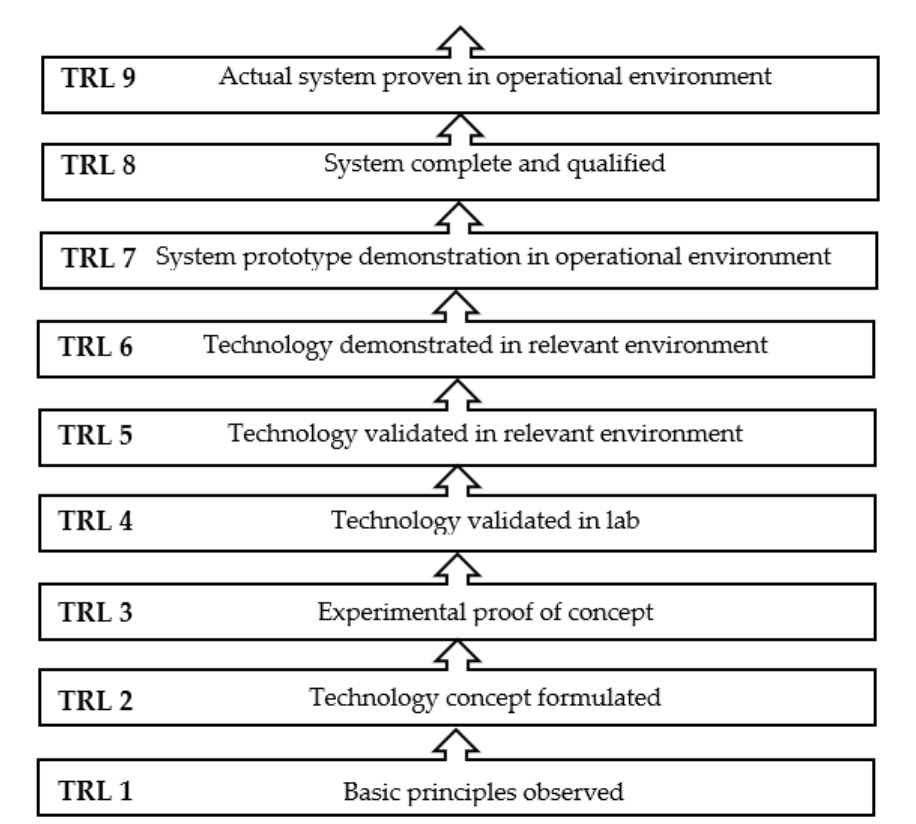
Figure 5. Technical readiness levels.